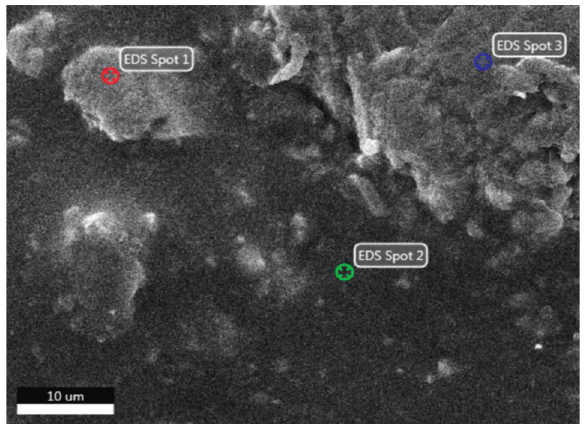
Figure 14: Schematic of EDS